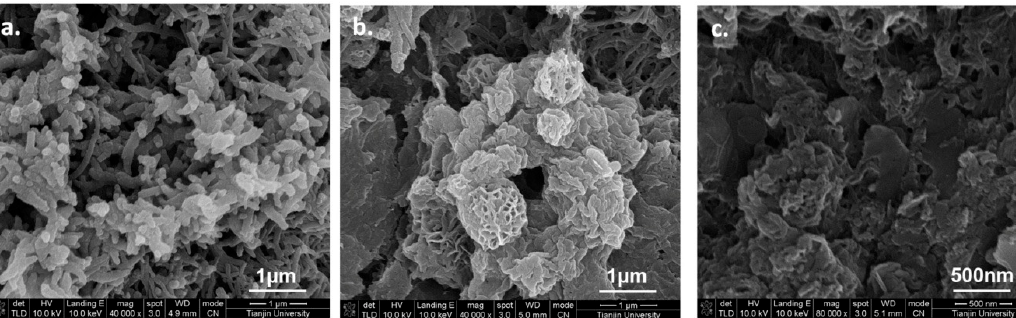
Figure 3. SEM images of ( a – c ) PANI obtained by in the used electrolyte solution [32].